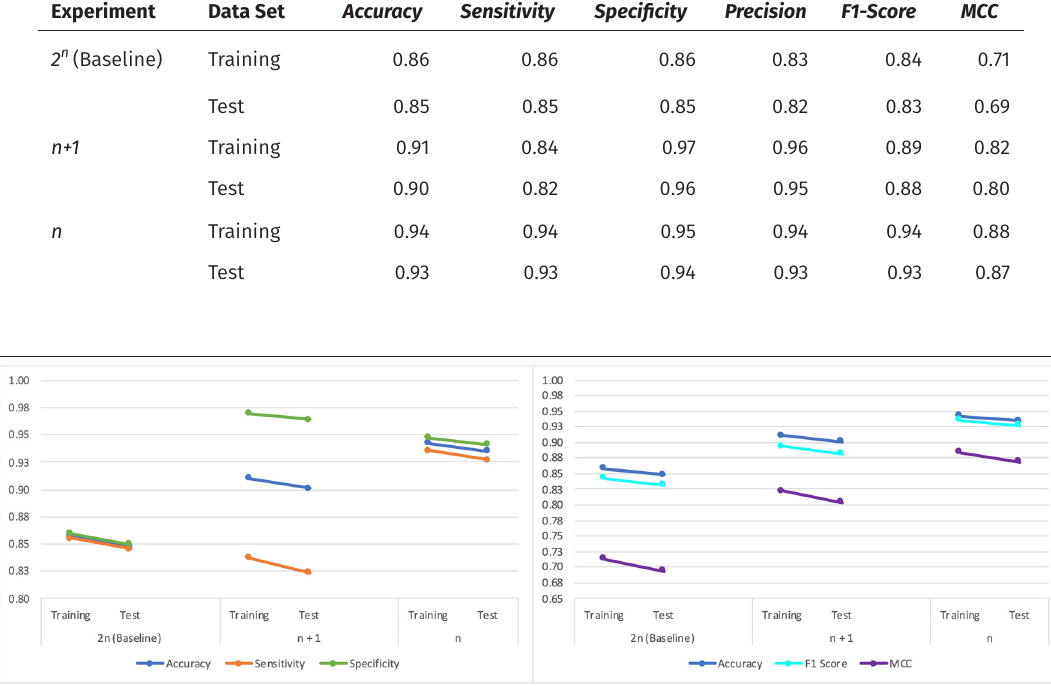
Figure 12: Results for the classifier's overall discriminatory